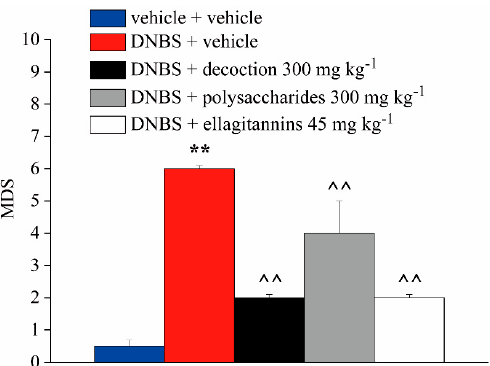
Figure 4. Effect of repeated treatment with pomegranate-based preparations on colon macroscopic damage. Animals were sacrificed 14 days after DNBS injection, and the colon portion was removed to perform the macroscopic analysis. The Macroscopic Damage Score (MDS) was used to quantify the tissue damage degree. Each value is the mean ± S.E.M. and represents the mean of six rats per group. * * p < 0.01 vs. vehicle + vehicle treated animals. ^^ p < 0.01 vs. DNBS + vehicle treated animals.